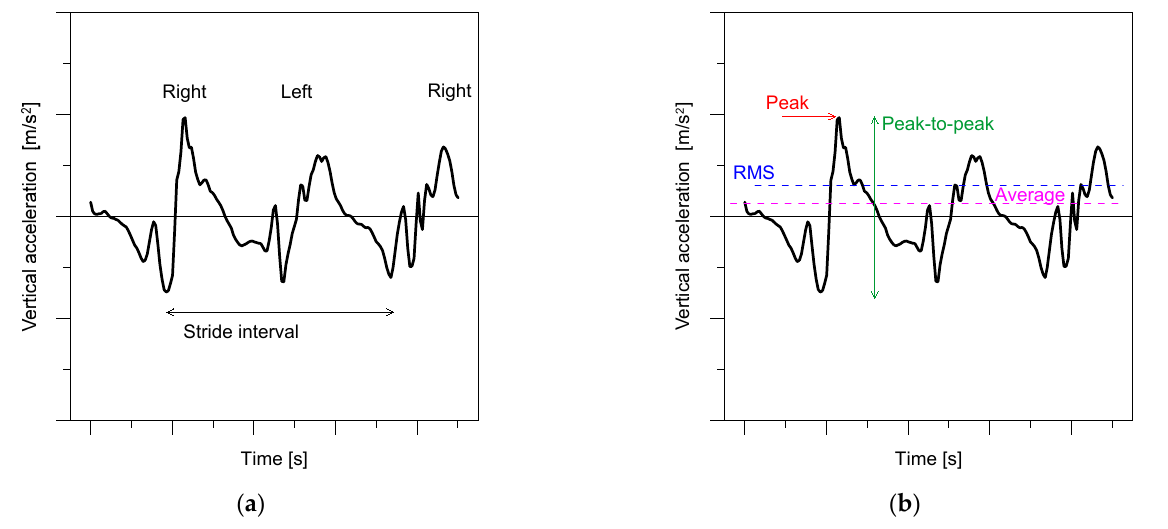
Figure 5. Analysis of body CoM records: example of ( a ) stride interval definition and ( b ) reference acceleration parameters.